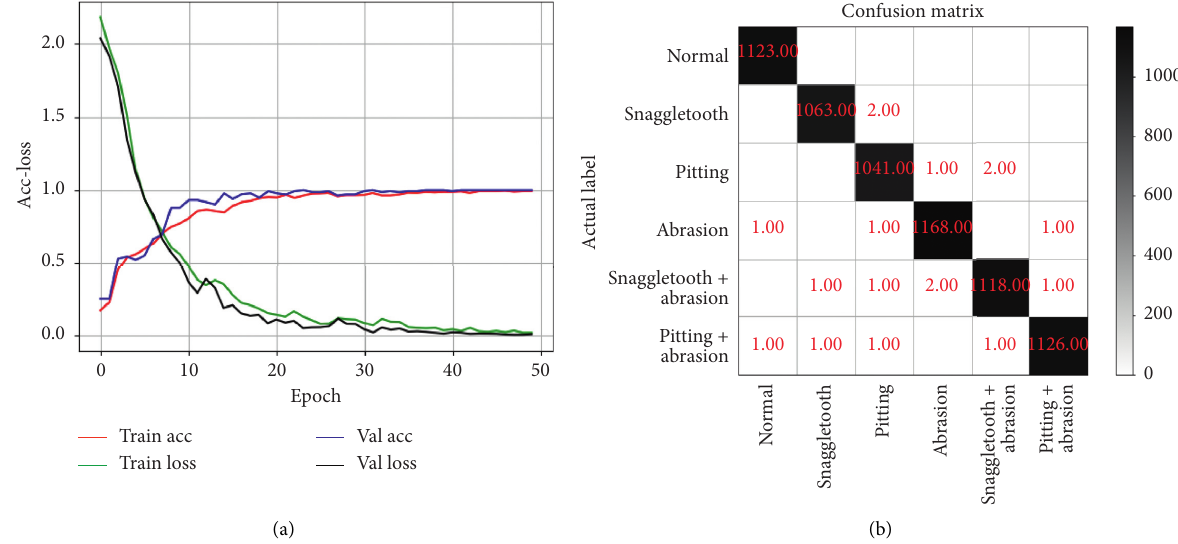
Figure 19: The optimization of CNN curve of accuracy rate and loss rate trained by PF of LMD and confusion